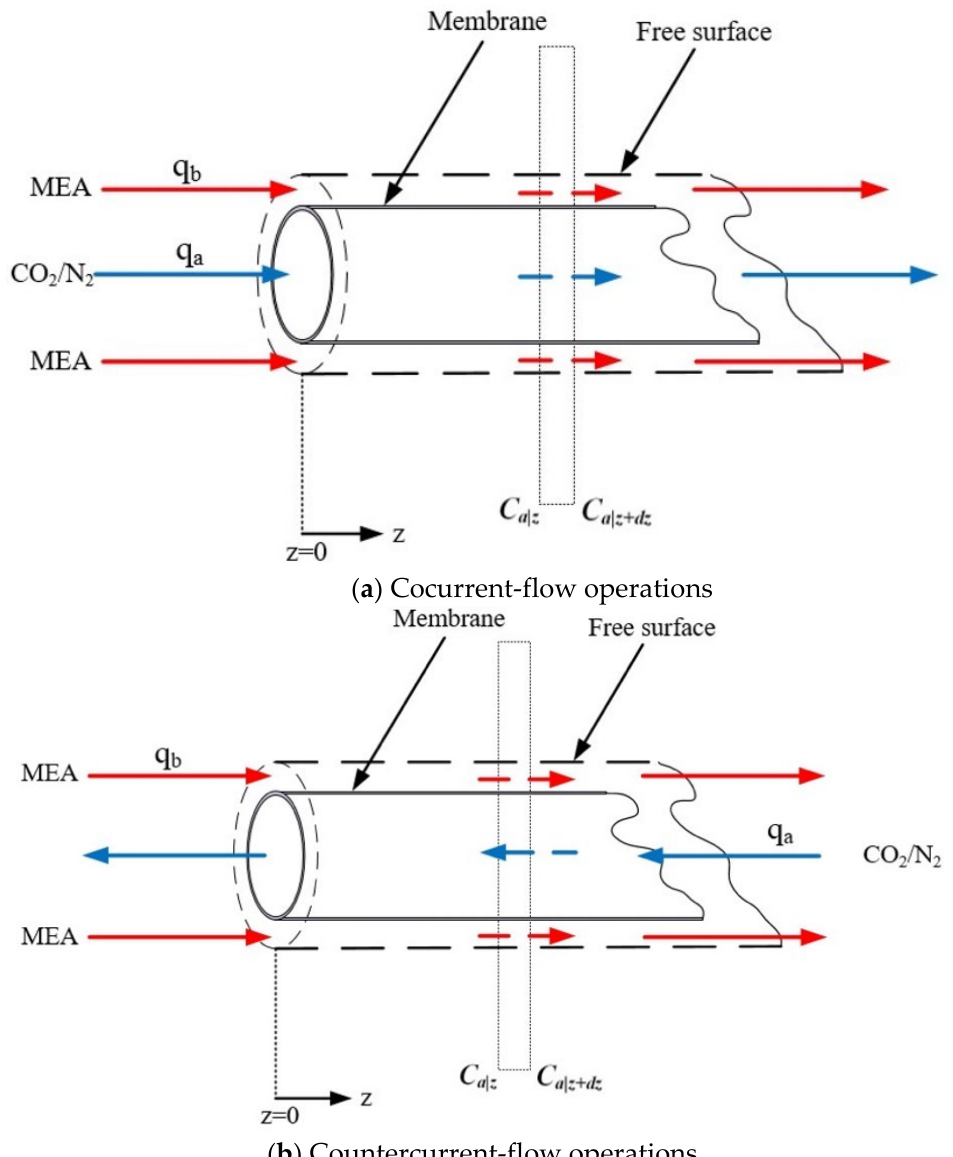
Figure 4. Schematic representation of CO 2 absorption by MEA for cocurrent- and countercurrent-flow operations in hollow-fiber membrane gas/liquid contactors.